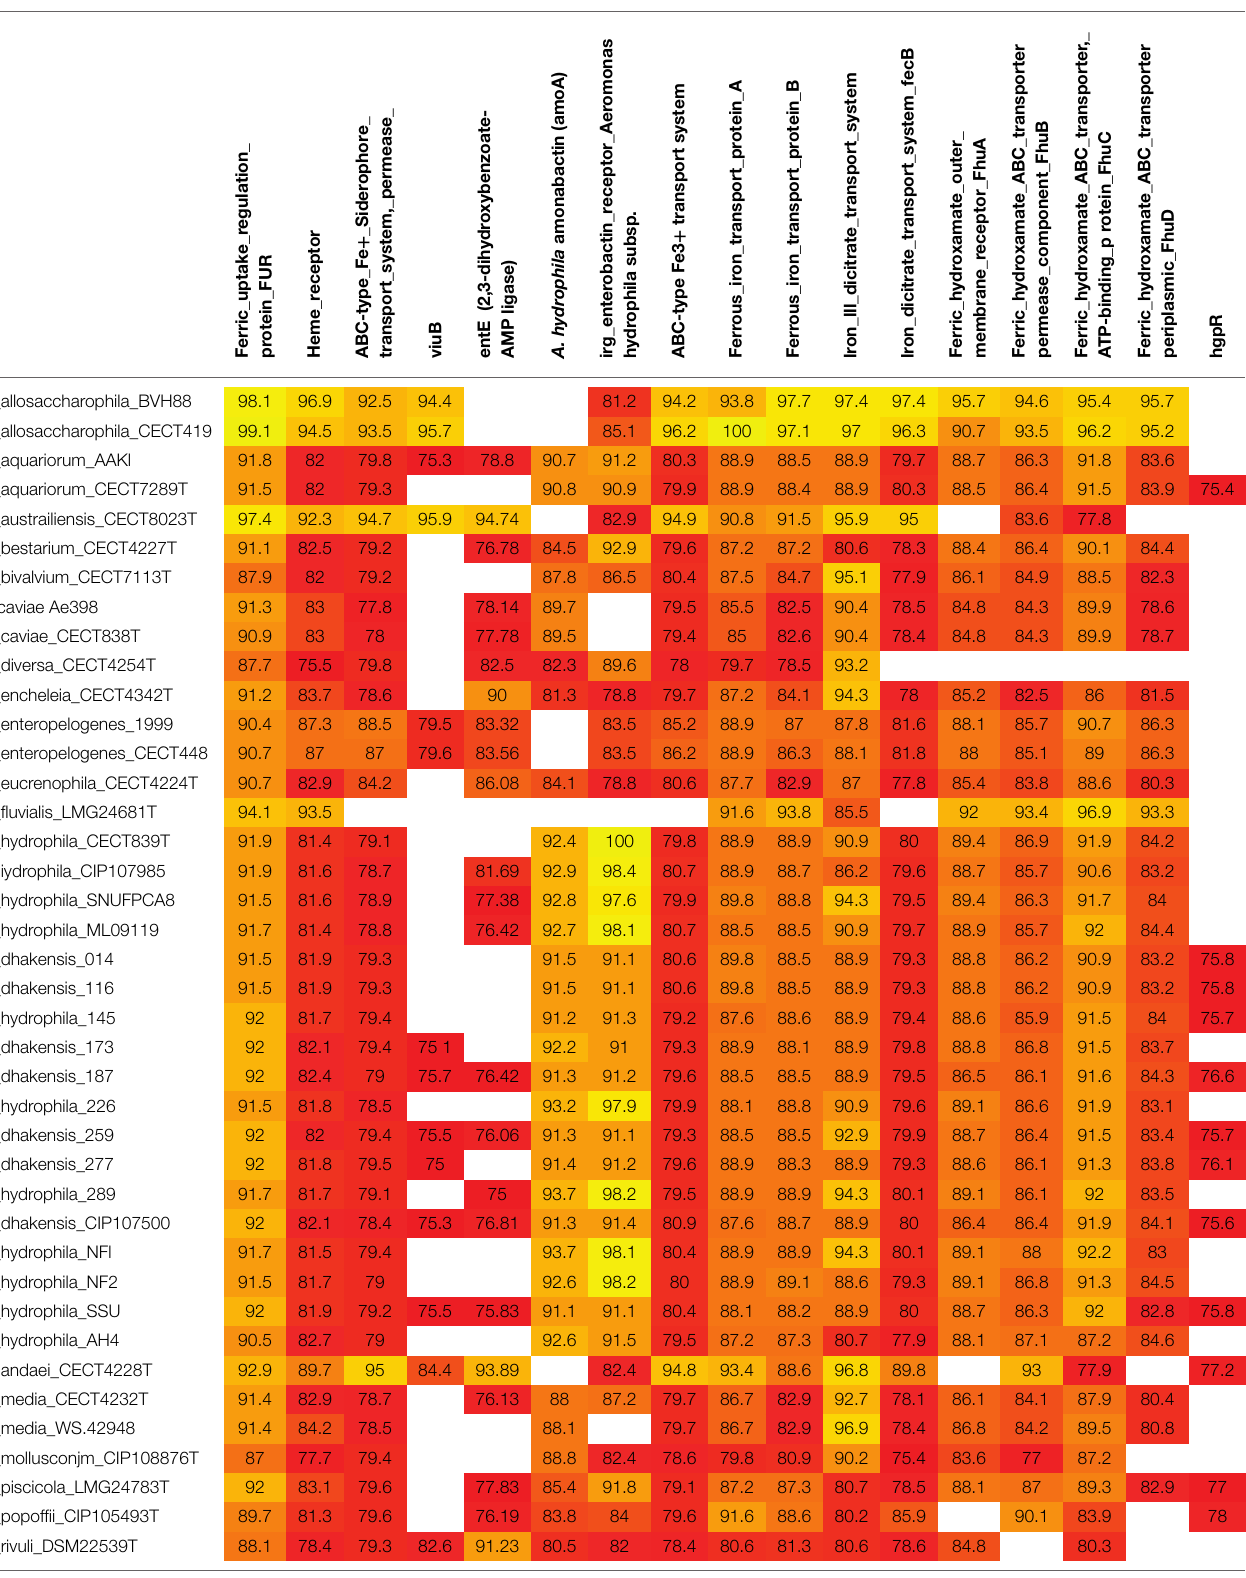
TABLE 2 | Nucleotide percentage identity to iron uptake genes in Aeromonas species and among A. veronii